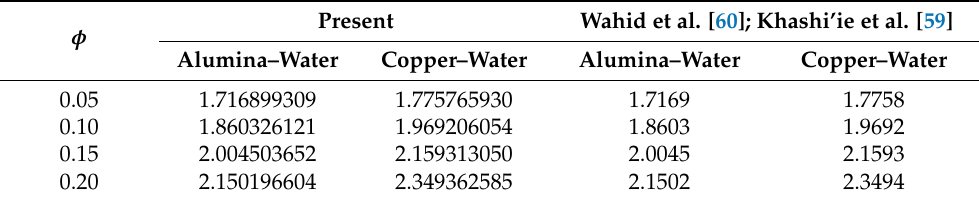
Table 6. Values of Re − 1/2 x Nu x when N = Rd = Du = Sc = Sr = λ = 0 and Bi → ∞ .